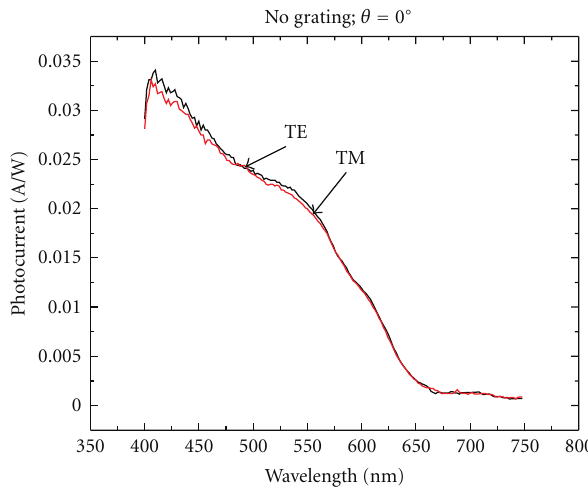
Figure 4: The TE and TM photocurrent responses of the P3HT- PCBM layer as a function of wavelength with no grating and at normal incidence.